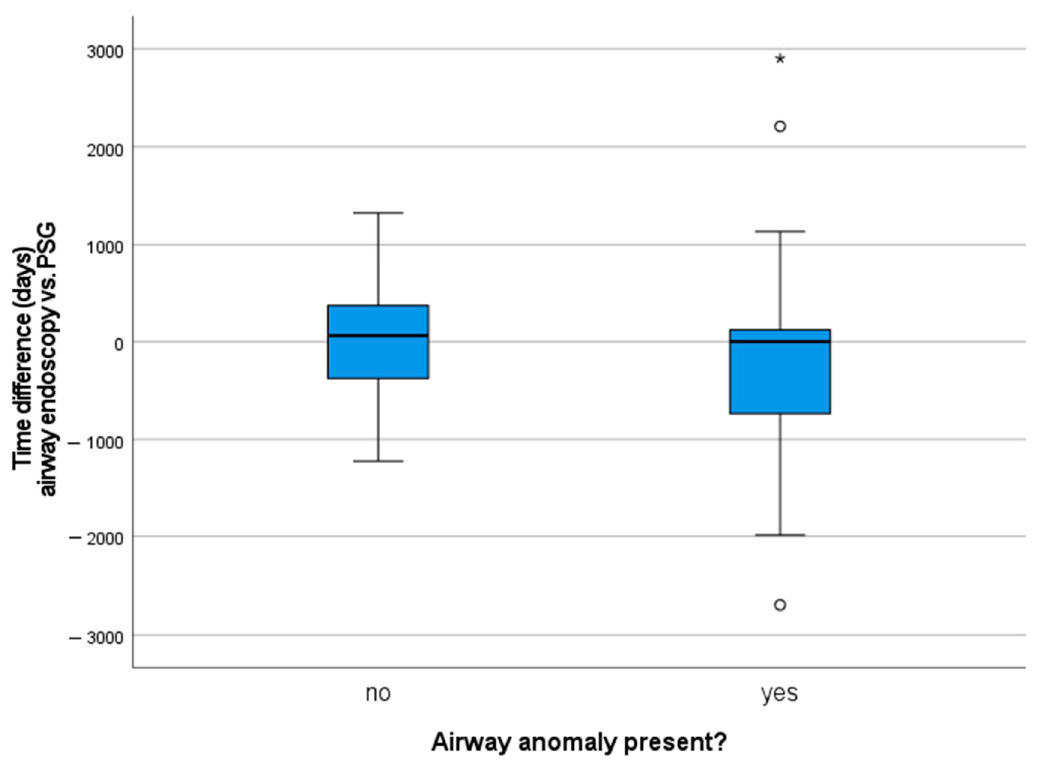
Figure 1. Comparison of the time difference between airway endoscopy and first PSG (in days). Outliers are displayed as ° or * for values deviating more than 1.5 or 3 interquartile range, respectively.